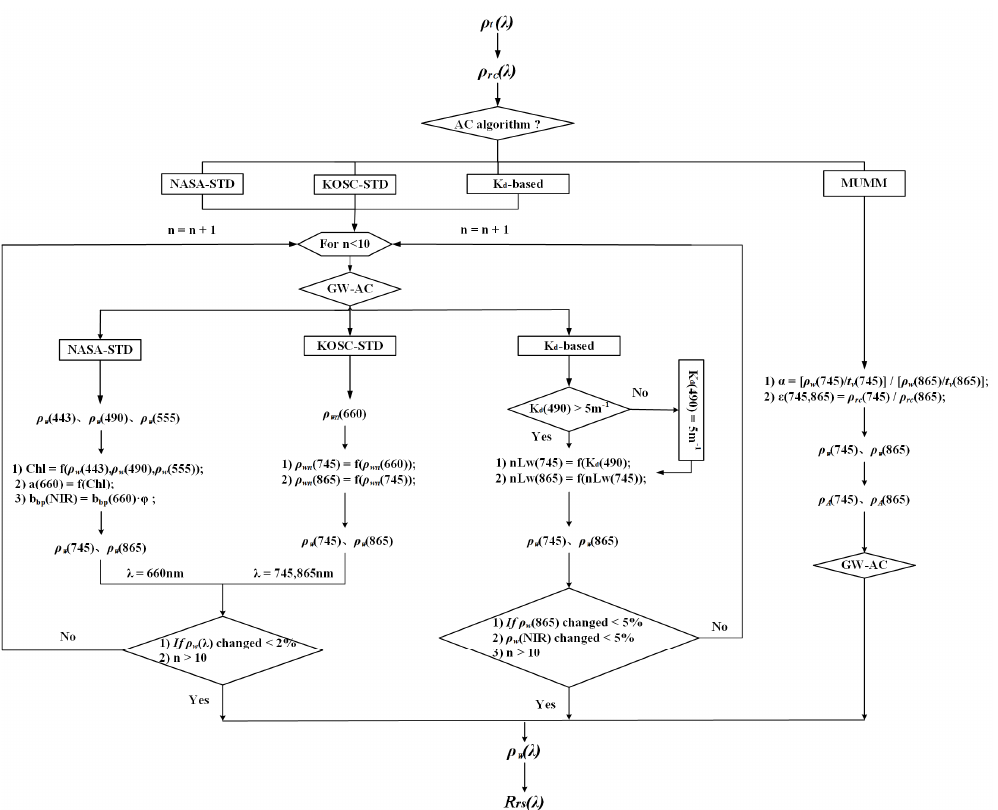
Figure 1. Schematic flowchart of the standard near infrared (NIR) algorithm of NASA (NASA-STD), the Korea Ocean Satellite Center ( KOSC-STD), the diffuse attenuation coefficient at 490 nm Kd (490)-based NIR correction algorithm (Kd-based), and the Management Unit of the North Sea Mathematical Models (MUMM) algorithms. NIR denotes both Geostationary Ocean Color Imager (GOCI) 745 nm and 865 nm.